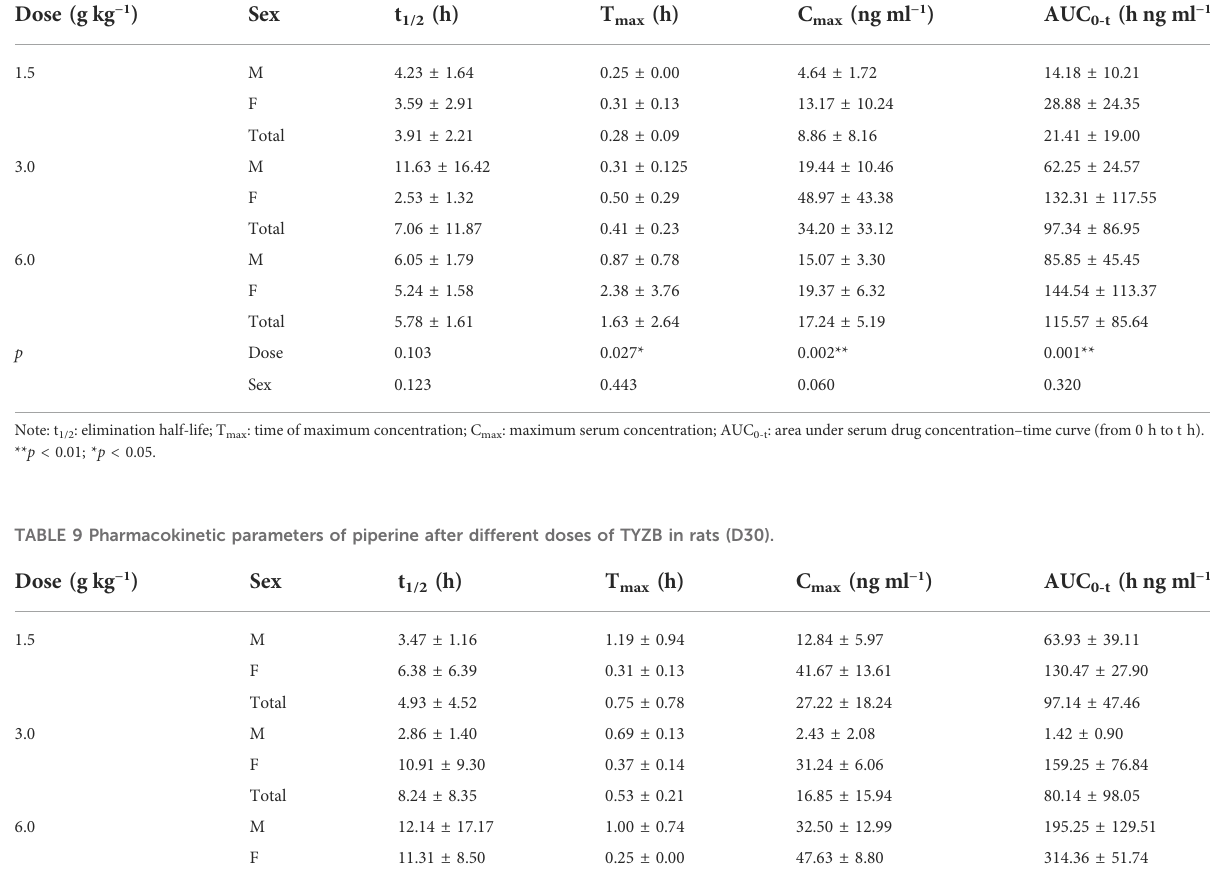
TABLE 8 Pharmacokinetic parameters of piperine after different doses of TYZB in rats (D15). Dose (g kg − 1 )